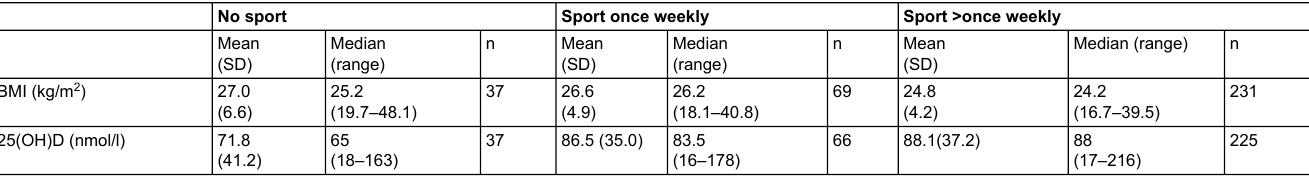
Table 5: Physical activity and serum 25(OH)D.